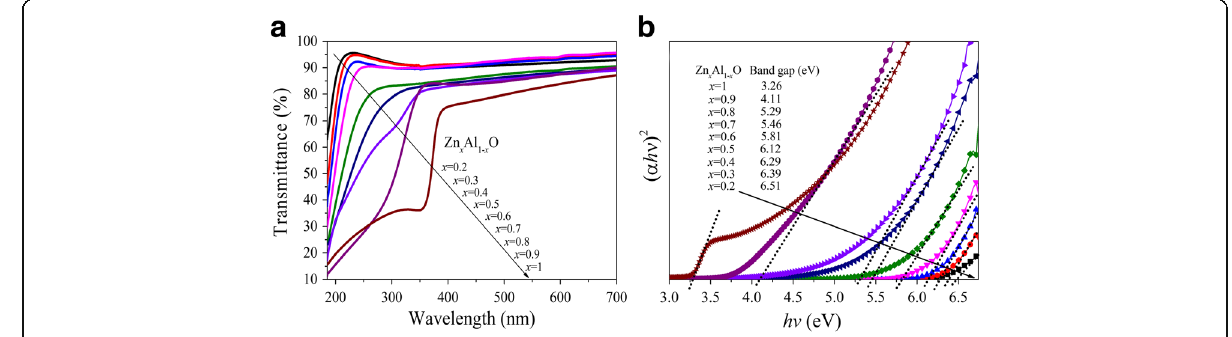
Fig. 2 Transmittance spectra ( a ) and the plots of ( α h ν ) 2 vs. photon energy ( b ) of Zn x Al 1- x O